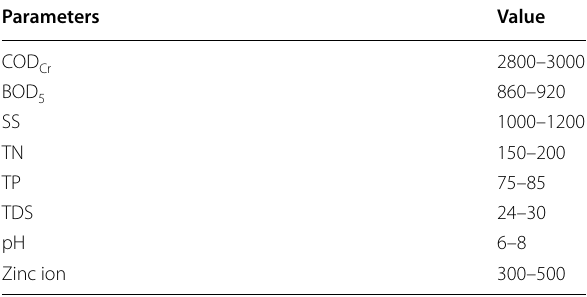
The units for the parameters except for pH and salt are in mg/L, TDS is